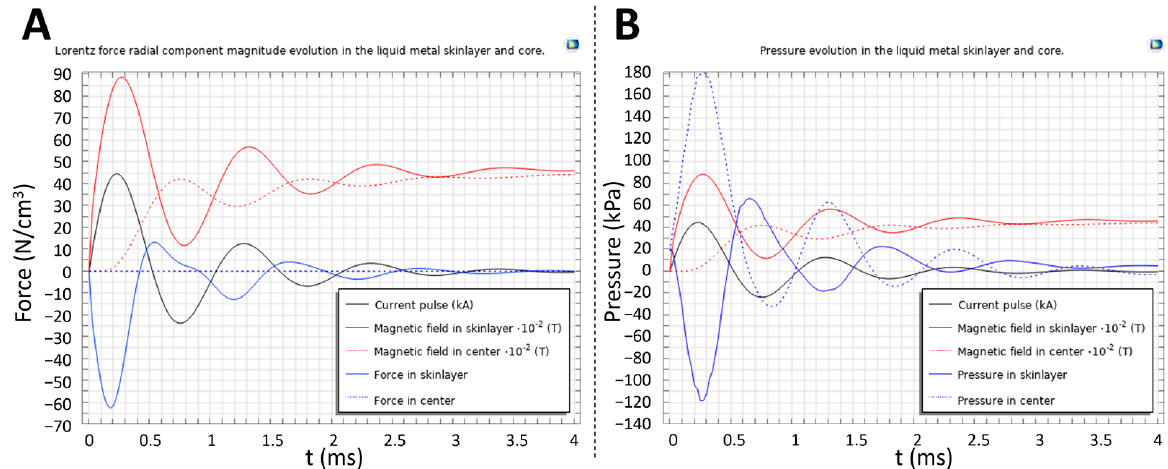
Figure 4. Graphs show electrical current in induction coil and resulting magnetic field. ( A ) EM force in liquid metal skin layer and center. ( B ) pressure in liquid metal skin layer and center.